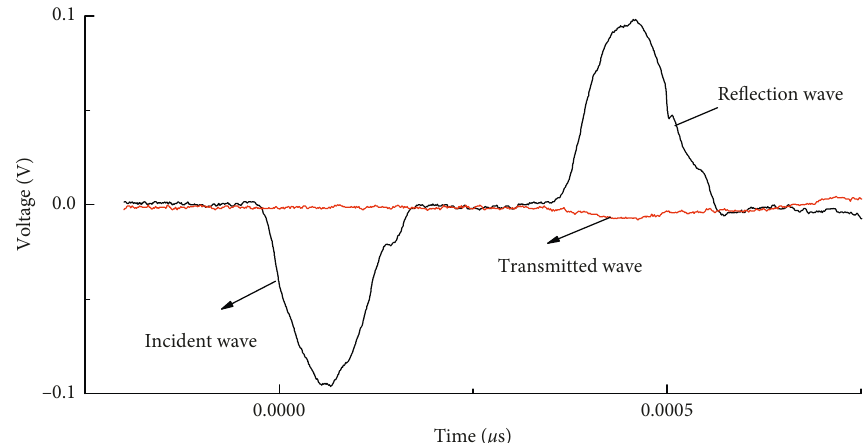
Figure 3: The typical waveform figure of SHPB